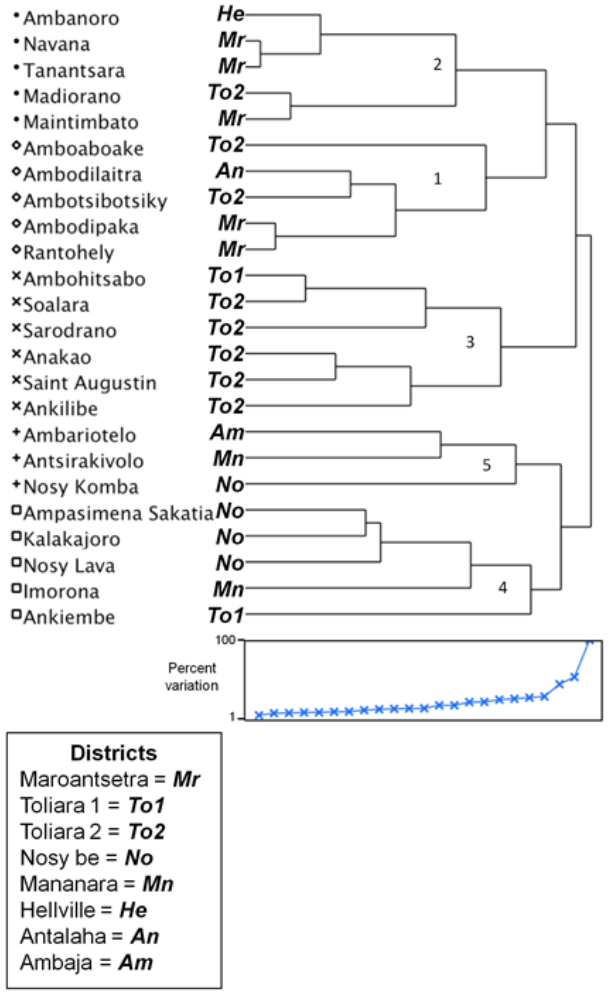
Fig. 2. Hierarchical cluster analysis (Ward method) based on fishers’ ratings of personal benefits from the five management restrictions. Clusters are numbered from the most to least positive rating of restrictions. These five cluster groups were used in subsequent analyses. The government districts of the sampled landing sites are shown in the legend.